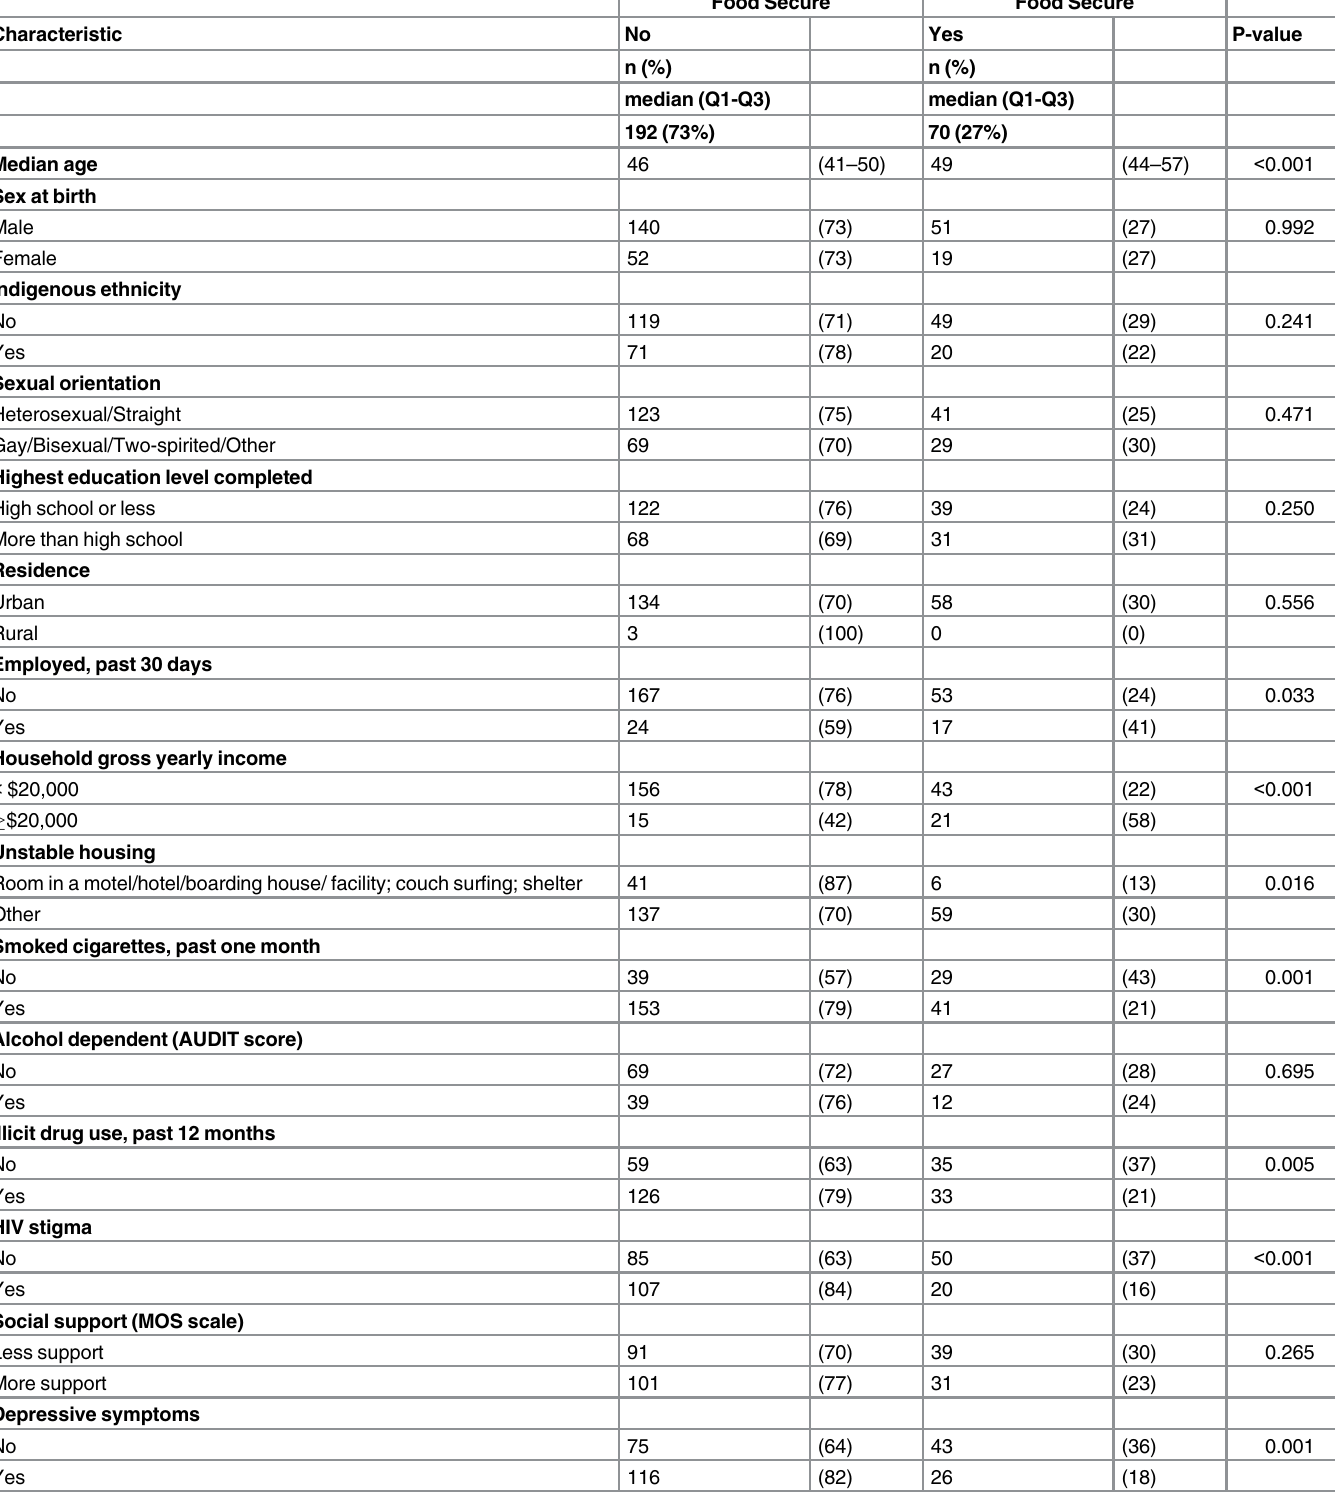
Table 2. Bivariate comparison of participant socio-demographic and behavioural characteristics, by food security status (n = 262).